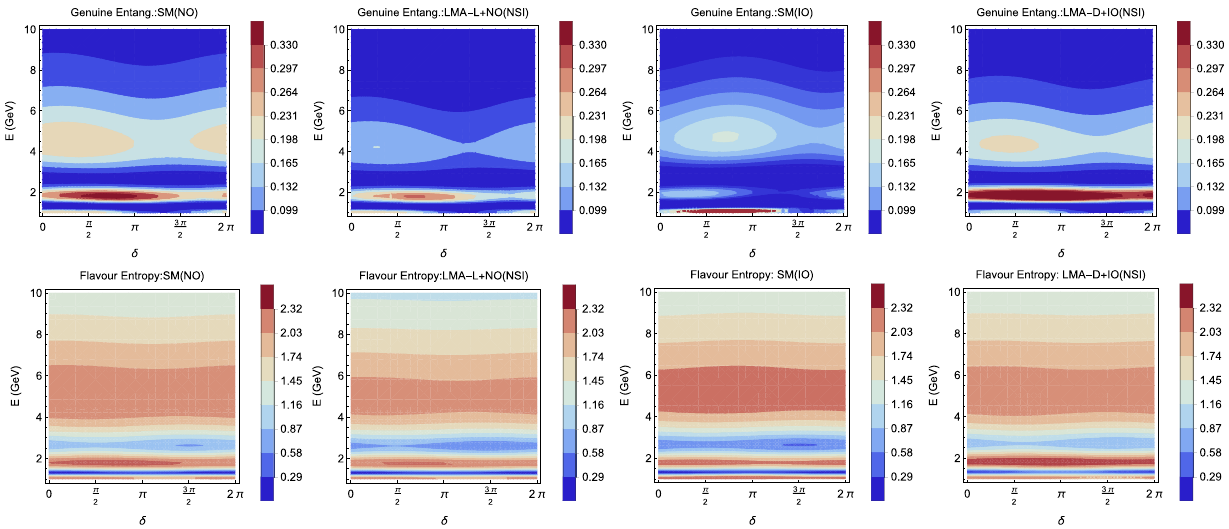
Fig. 3 Genuine tripartite entanglement G (upper figures) and flavour entropy S (lower figures) have been plotted in the E − δ plane in case of SM-interaction with NO (first column), LMA-Light + NO (sec-